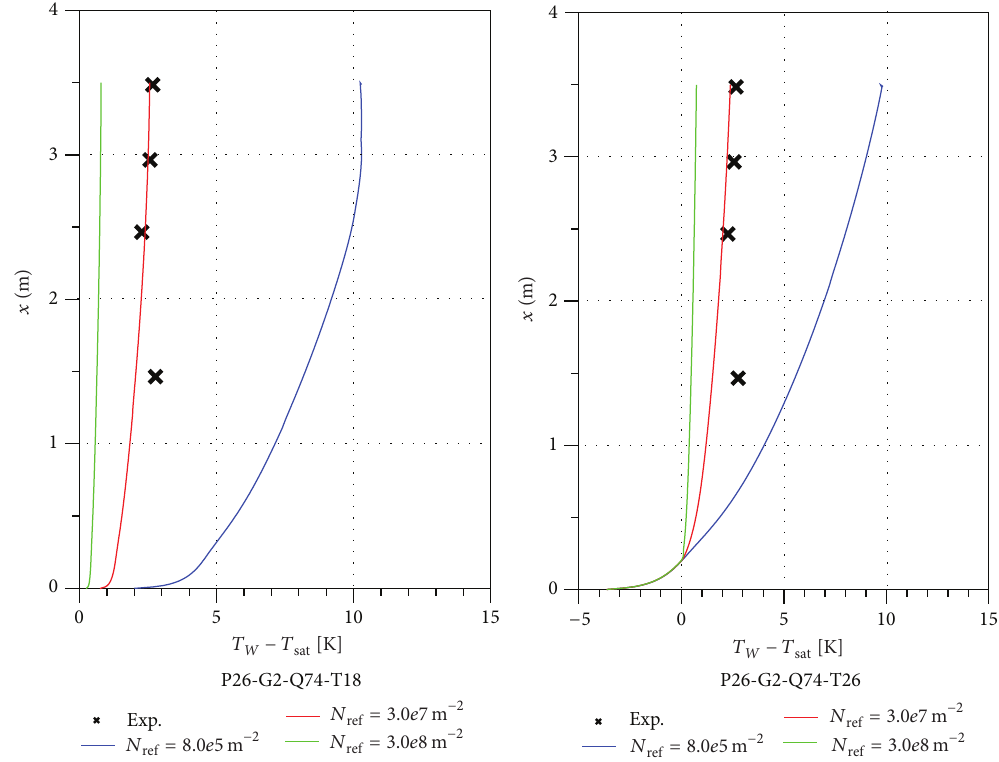
F 4: Wall superheat depending on the reference nucleation site density